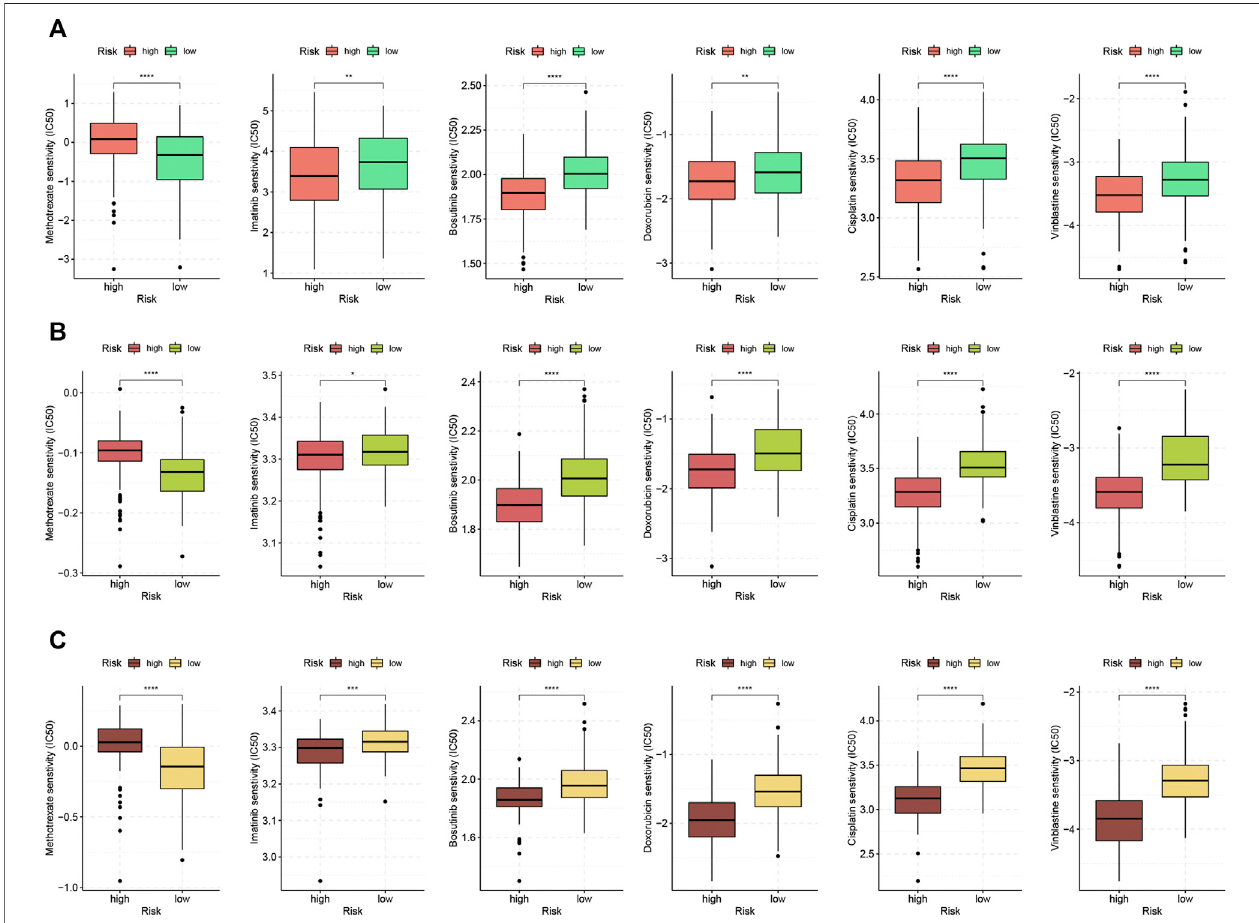
FIGURE 9 | Chemotherapeutic response analysis. Boxplots comparing differences in half-inhibitory concentration (IC50) values of six anti-tumor drugs between high- and low-risk score groups in (A) TCGA, (B) GSE84437, and (C) GSE62254 ( p p < 0.05, pp p < 0.01, ppp p < 0.001, pppp p < 0.0001).